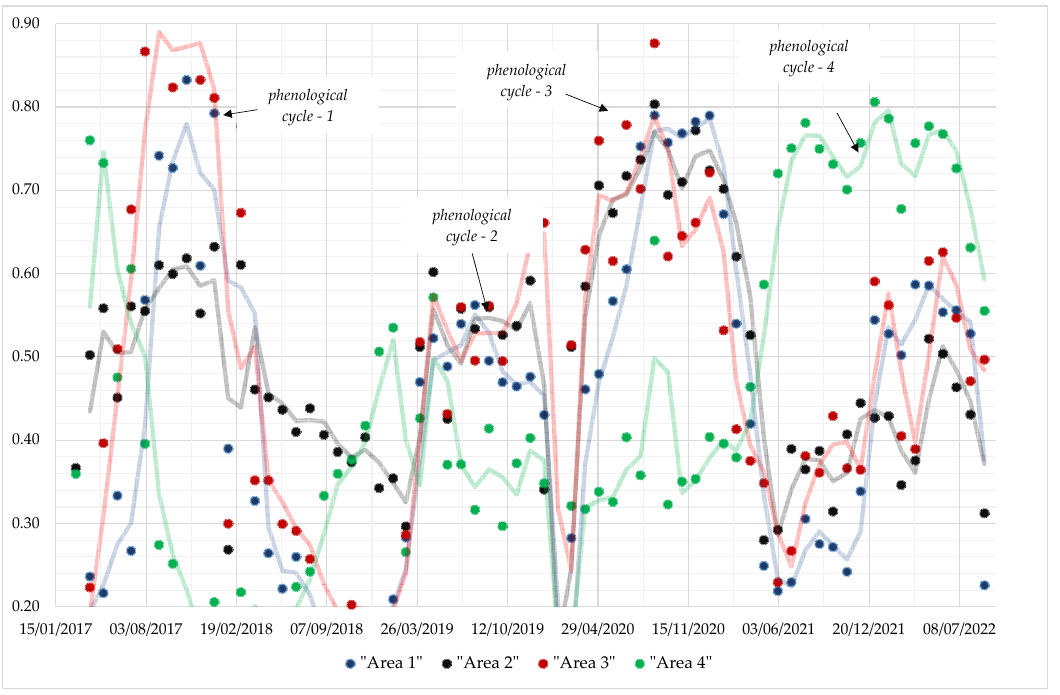
Figure 11. Phenological profiles are shown as dots over areas 1, 2, 3 (archaeological proxies), and 4 (cultivated area). A moving average filter of 2 periods (line) was applied to smooth the datasets.